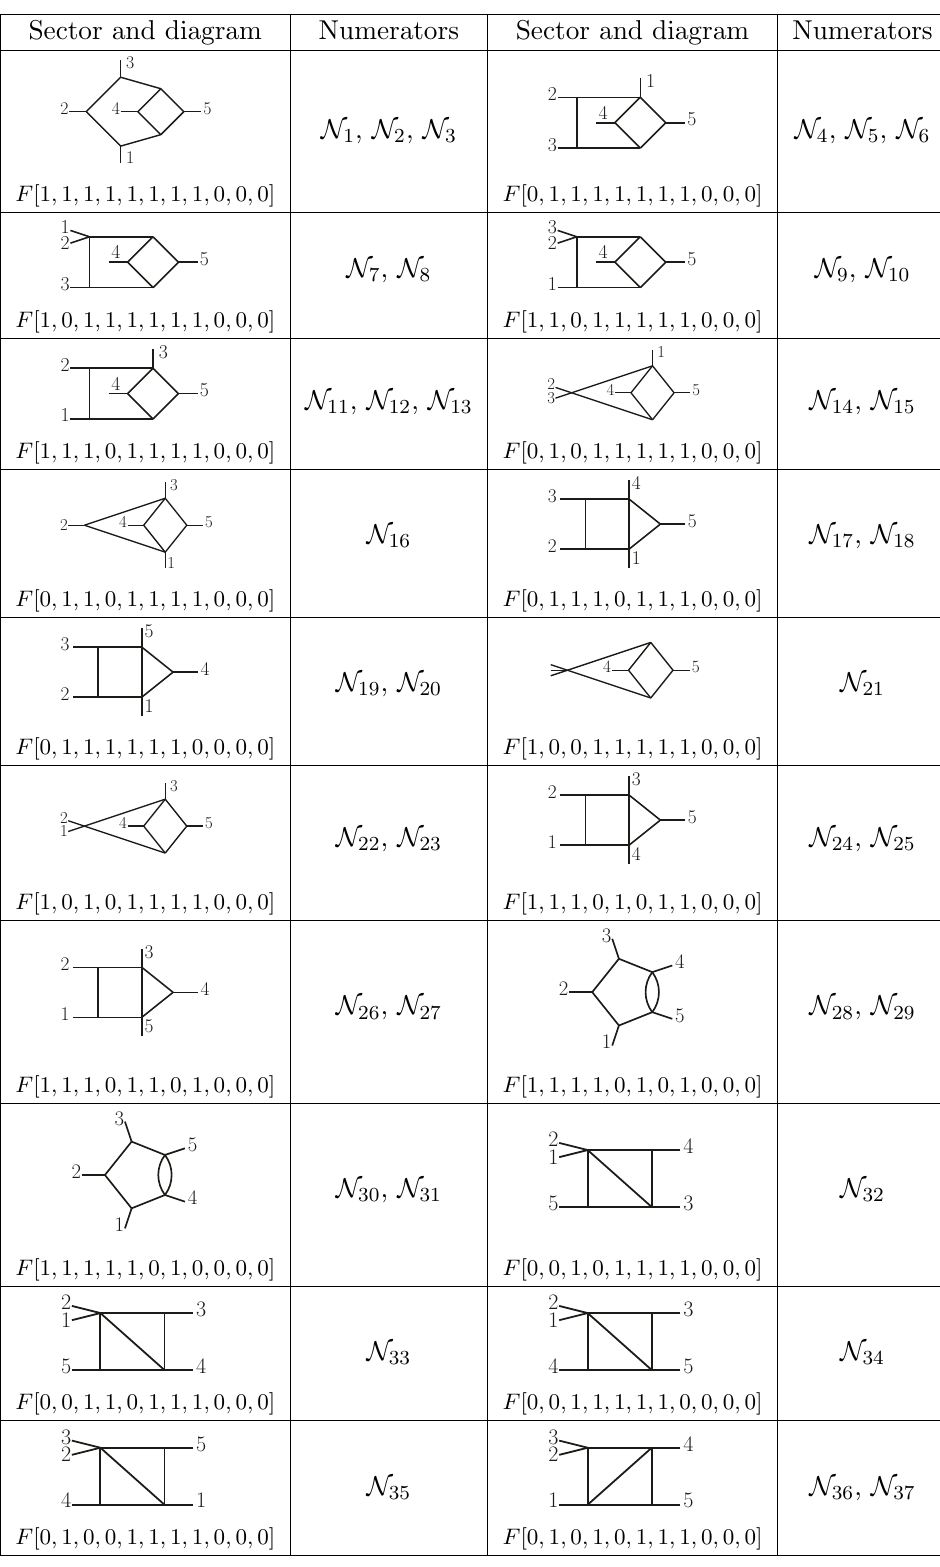
Table 1 . Diagrammatic representation of each sector and associated